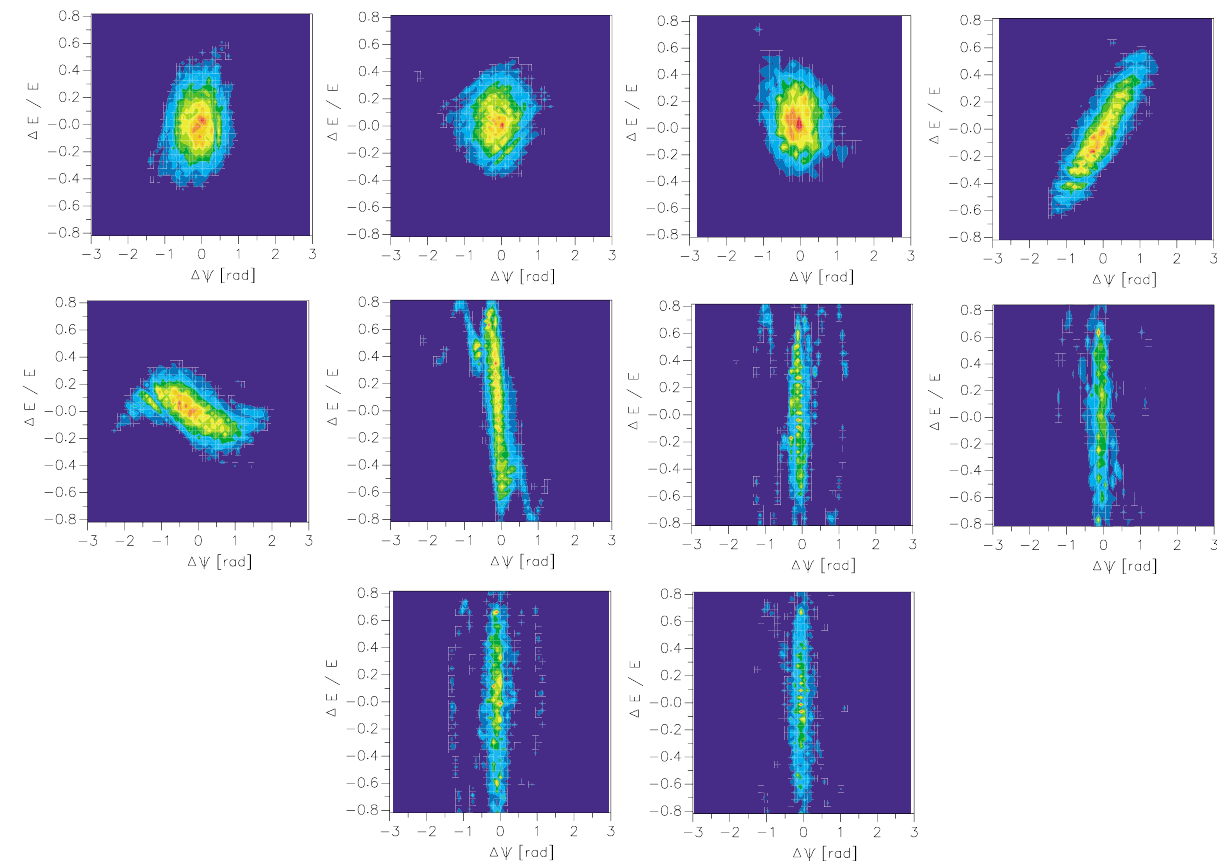
FIG. 6. (Color) Evolution of the phase space distribution during rebucketing. Reconstructions are performed at each 25th